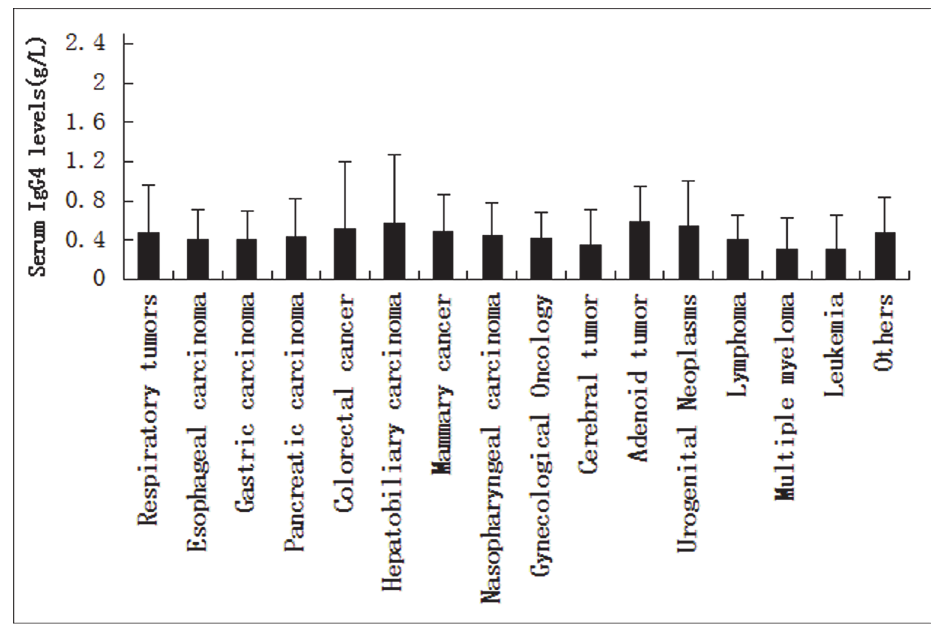
Fig 4. Serum IgG4 levels in patients with different types of tumors. (mean ± SD = 0.48 ± 0.49g/L vs. 0.40 ± 0.31g/L vs. 0.40 ± 0.29g/L vs. 0.43 ± 0.39g/L vs. 0.51 ± 0.69g/L vs. 0.57 ± 0.69g/L vs. 0.49 ± 0.38g/L vs. 0.44 ± 0.35g/L vs. 0.42 ± 0.26g/L vs. 0.35 ± 0.37g/L vs. 0.58 ± 0.36g/L vs. 0.55 ± 0.46g/L vs. 0.40 ± 0.25g/L vs. 0.30 ± 0.32g/L vs. 0.31 ± 0.34g/L vs. 0.47 ± 0.37g/L).